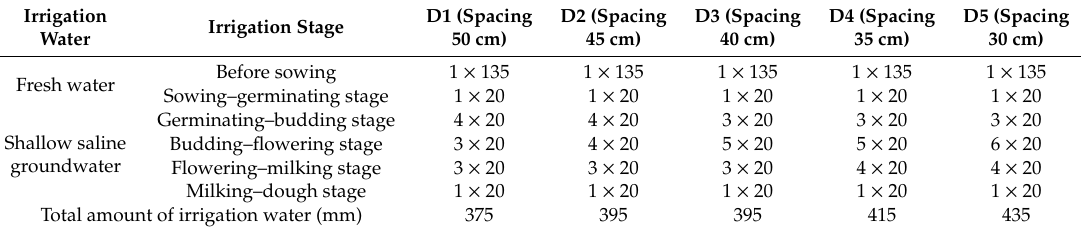
Table 5. The irrigation schedule for di ff erent planting densities in